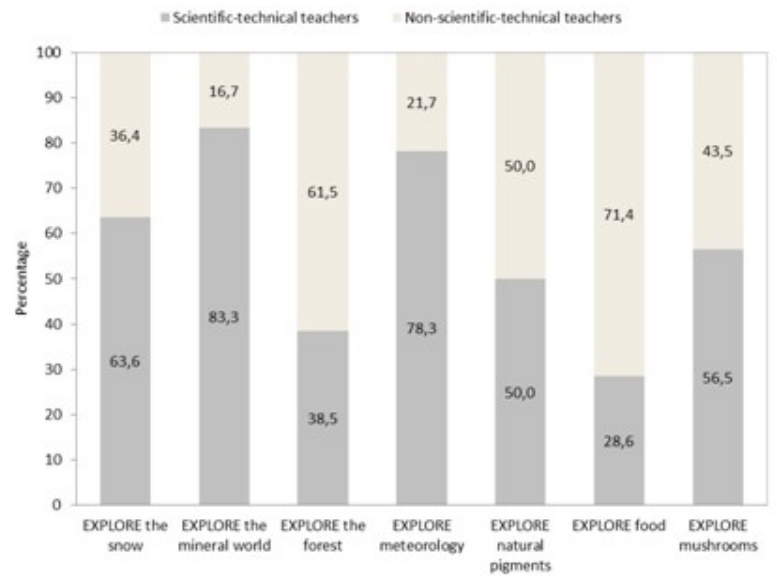
Figure 1. Percentage distributon of teacher partcipants in 2013 according to their specifc feld of expertse